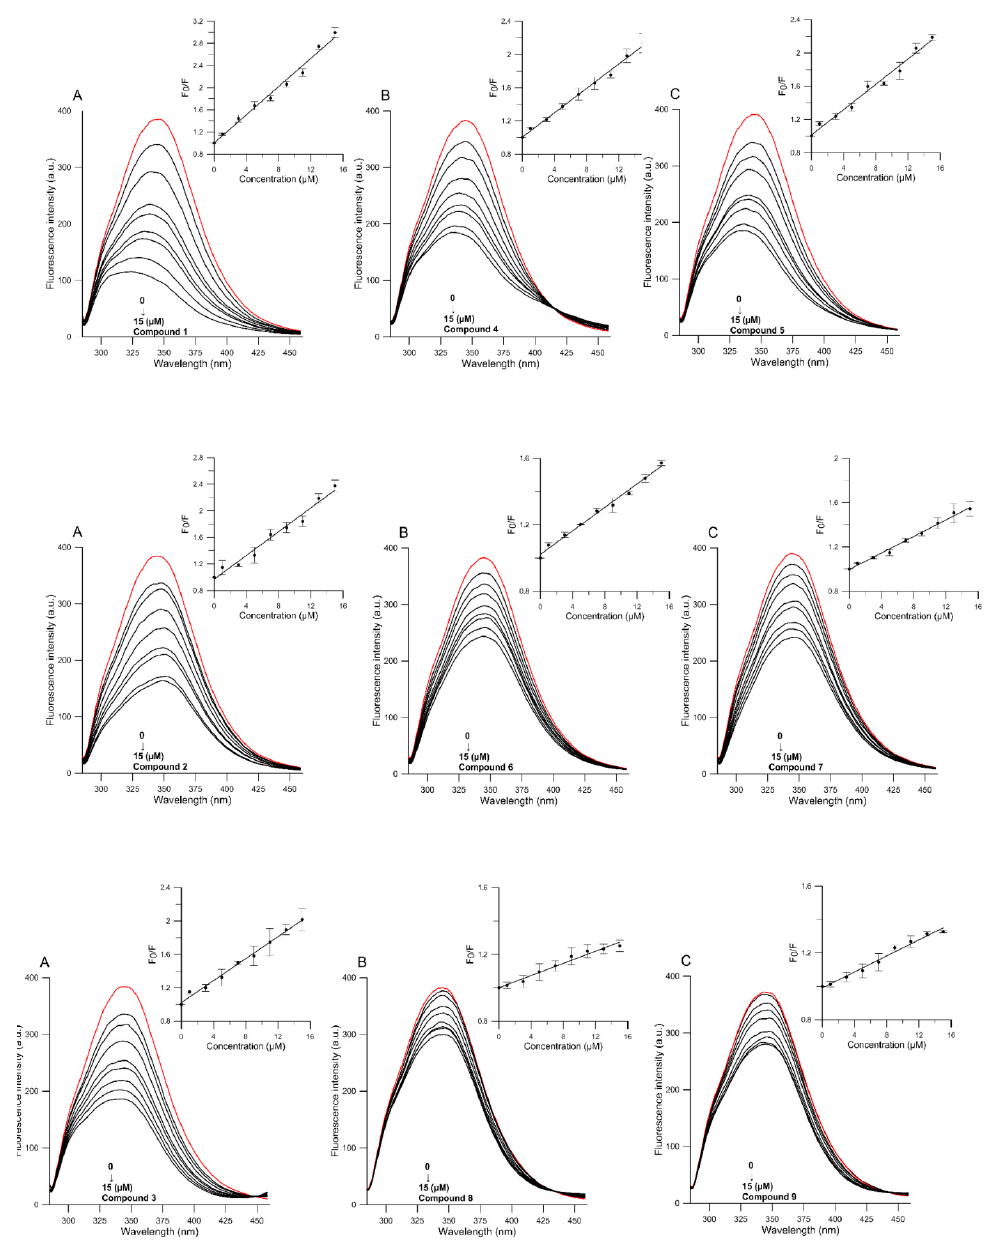
Figure 4. Emission spectra of HSA in the presence of various concentrations of tested compounds and Stern-Volmer plots of F o /F against the concentration of tested compounds (HSA = 1.5 × 10 − 5 M, λ ex = 280 nm, T = 310 K). Control is marked red and consecutive spectra of the studied compounds (marked grey) are in the following concentrations 1, 3, 5…, 15 µM. Top graphs present xanthohumol ( 1 ) and its glycosides ( 4 – 5 ); middle graphs present α , β -xanthohumol ( 2 ) and its glycosides ( 6 – 7 ); and bottom graphs present aurone 3 and its glycosides ( 8 – 9 ) (( A ) aglycones ( 1 – 3 ); ( B ) glycosides ( 4 , 6 , and 8 ); and ( C ) 4- O -methylglycosides ( 5 , 7 , and 9 )). The following Stern-Volmer equation [47] was used to analyze the fluorescence quenching mechanism induced by tested compounds at different temperatures (300, 305, 310 and 315 K).